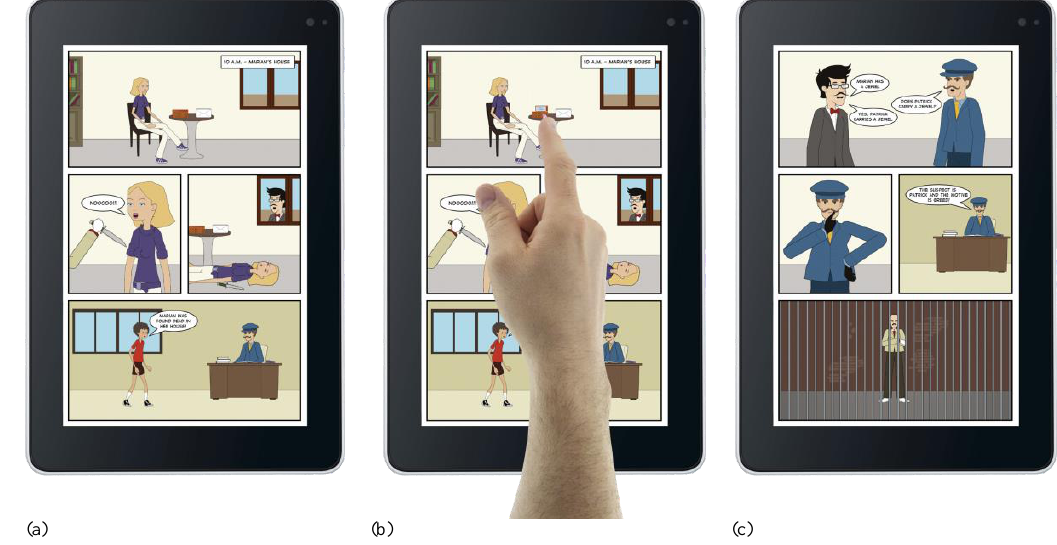
Fig. 4. The interactive comic book: (a) a sample page; (b) the user touching an interactive object; (c) a page containing the modified events resulting from the user intervention. V. R ELATED W